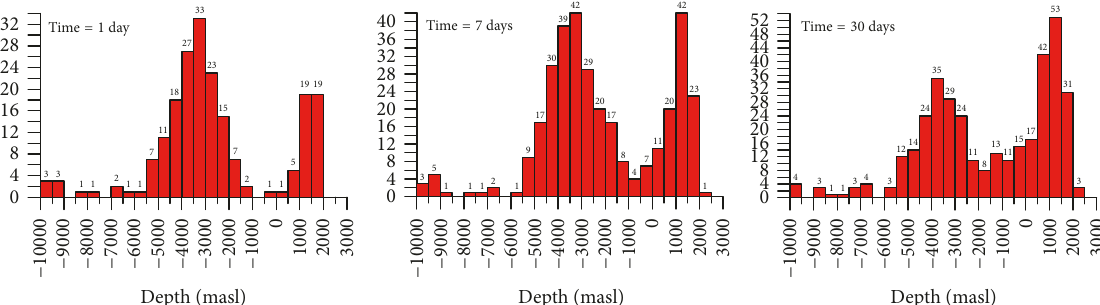
Figure37: HistogramsoftheFrac-Digger sensitivity oftheestimated depths ofdikes tothetimedifference ( 𝛿𝑡 )allocated totheplane-oriented cluster.